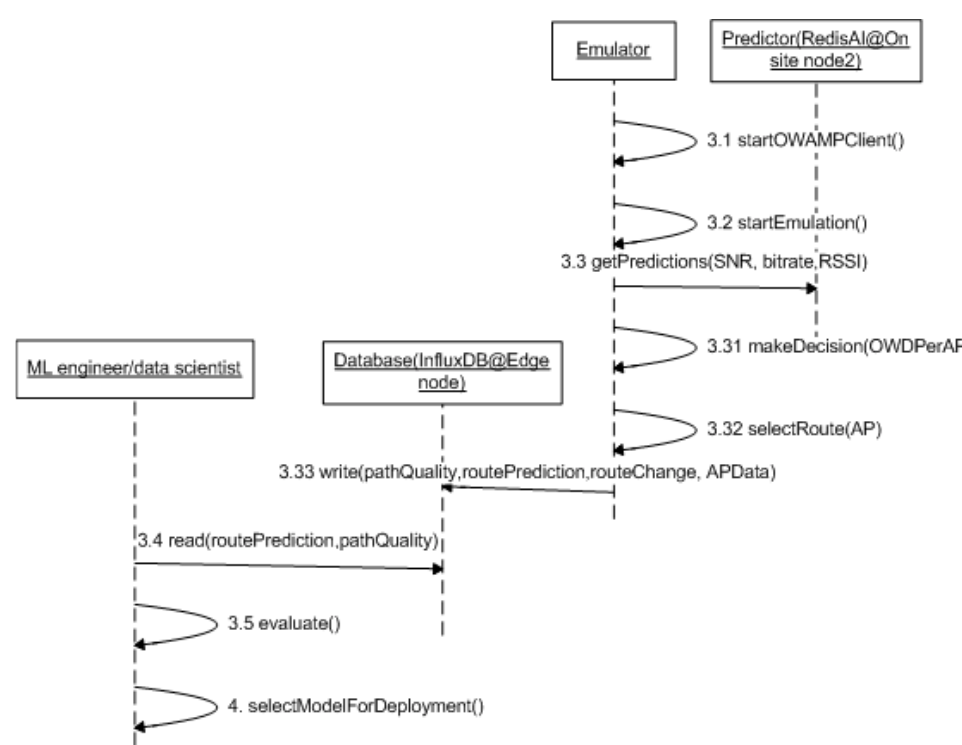
Figure 8. ML-based inference for facilitating decision making on multi-access routing.